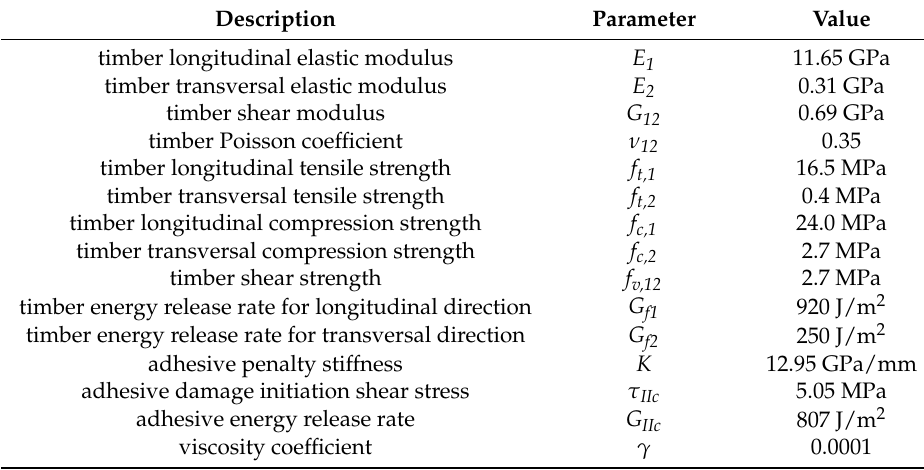
Table 1. Material parameters tested, selected, and used in numerical